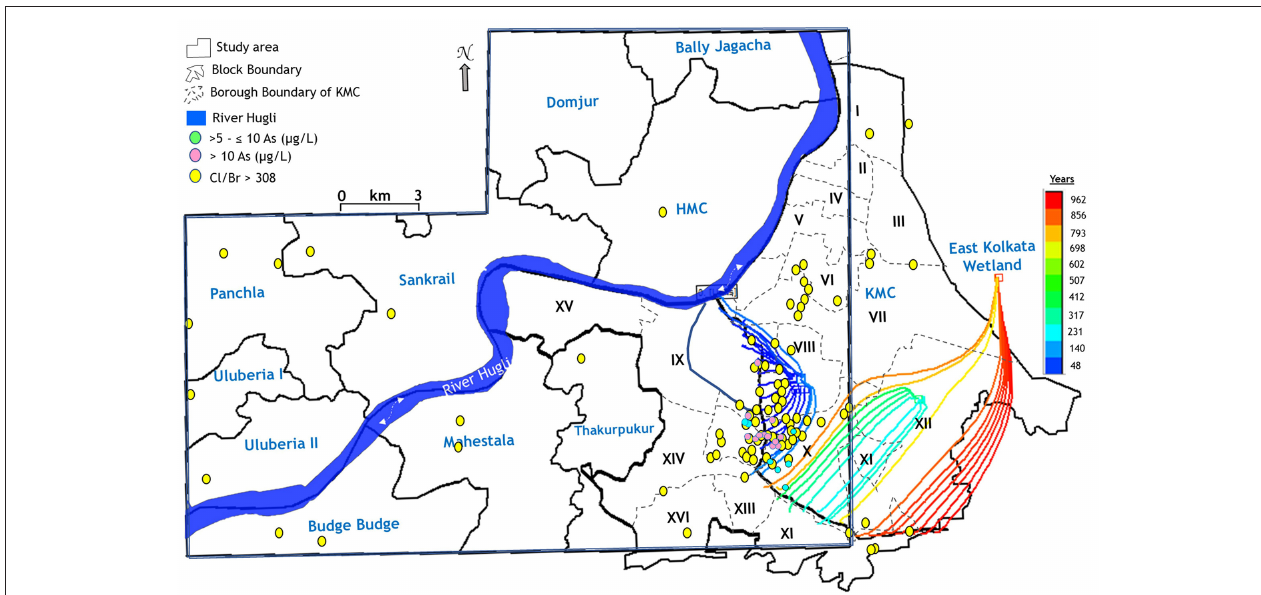
FIGURE 13 | Path lines of forward tracked particle from Tolly’s Nala under present development pumping conditions. Groundwater samples of McArthur et al. (2018) and the present study having higher concentrations of As and wastewater where Cl/Br > 308 are plotted in the study